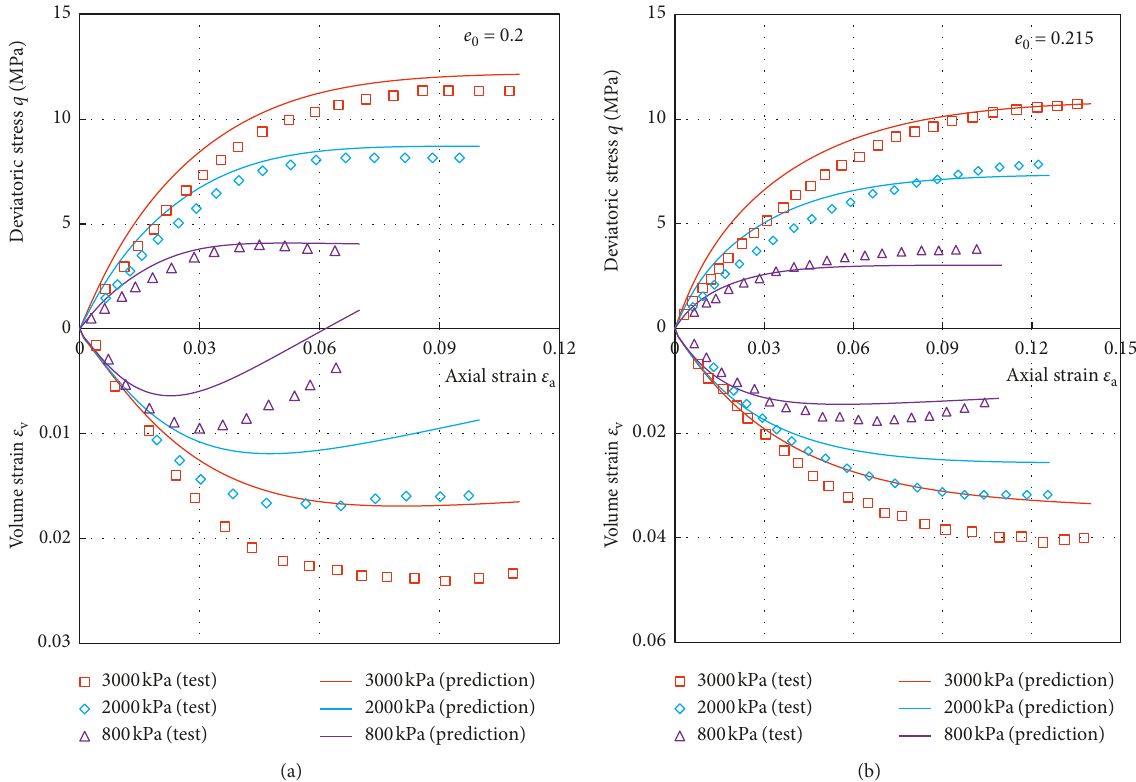
Figure 6: Experimental data and numerical predictions of the enhanced model by introducing Equation (17): (a) coarse granular soil I; (b) coarse granular soil II.